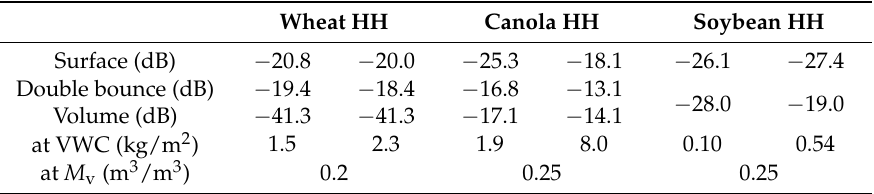
Table 4. Decomposition of modeled total σ 0 into scattering mechanism at specified levels of VWC and soil moisture ( M v ) using SMAPVEX12 data. The coherent model for soybean does not distinguish double-bounce from volume scattering. For brevity, only the cases for HH are tabulated. Wheat HH Canola HH Soybean HH Surface